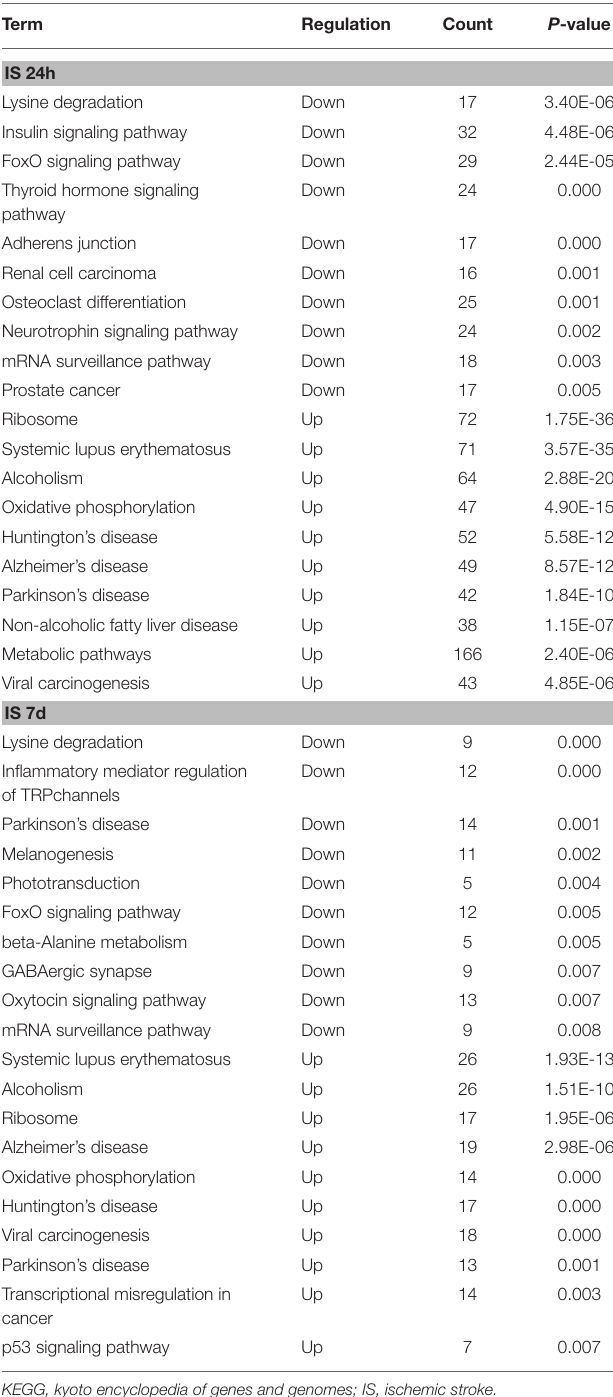
TABLE 4 | Top 10 significant KEGG pathways for differentially expressed LncRNAs and